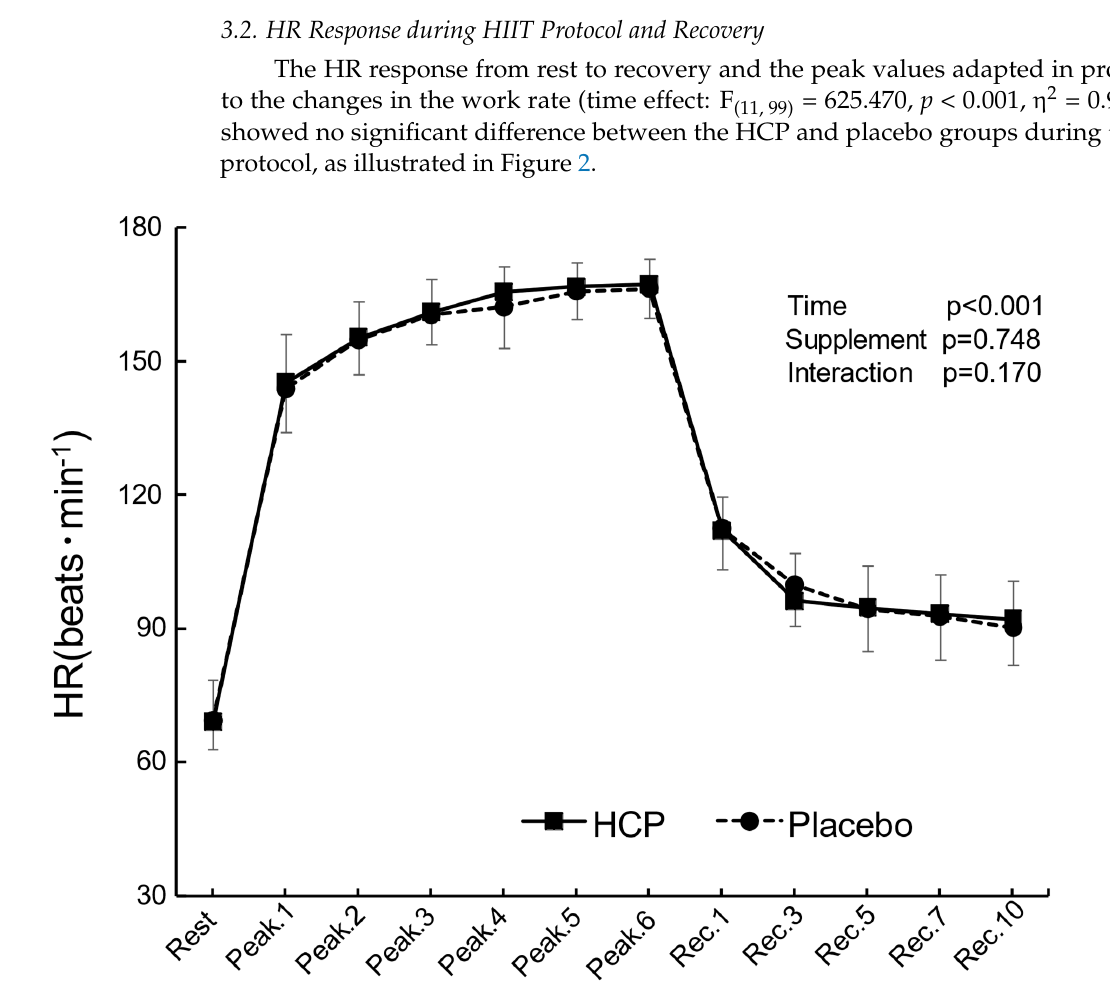
Figure 2. The subjects’ heart rate (HR) response at rest and the peak values during the 7 s all − out bout for each set (Peak.1~6) and the recovery period (Rec.1~10) between the HCP and placebo groups. Error bars: SD. The HR showed no significant difference between the groups.